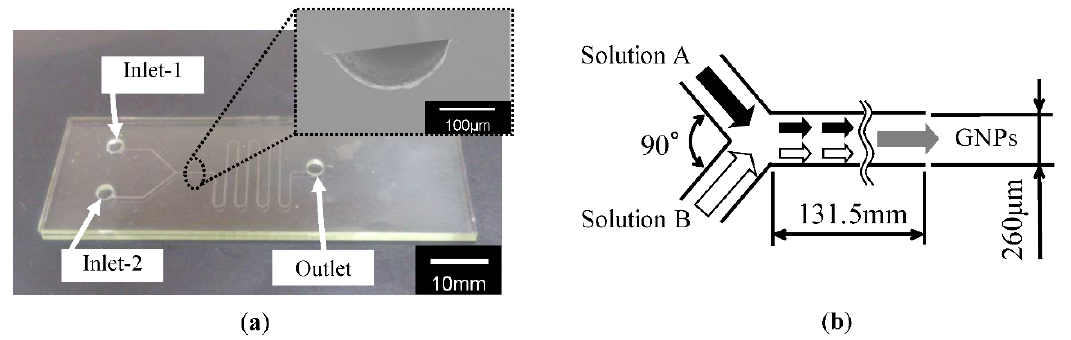
Figure 2. ( a ) Photograph of the fabricated glass microfluidic device. ( b ) Schematic image of a joint section in the